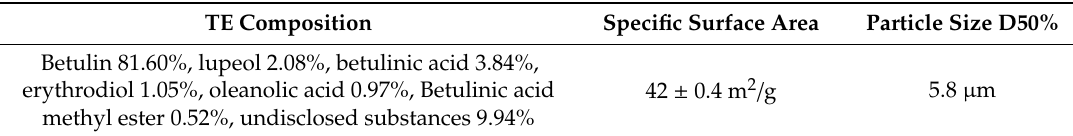
Table 1. Physical-chemical characteristics of the dry birch bark extract used